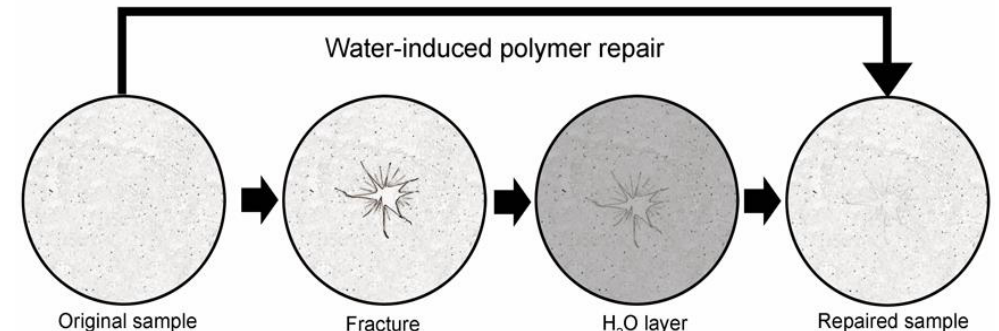
Figure 2. Schematic of water-induced repair of fractured pectin films. The glass phase pectin film is fractured using a controlled uniaxial load with a 5 mm stainless steel probe (2 mm/sec). The fractured film is placed on a thin layer of distilled water (1.6 to 1.8 mm) for 8 h at 25 °C followed by optical and mechanical analysis of the repaired films.